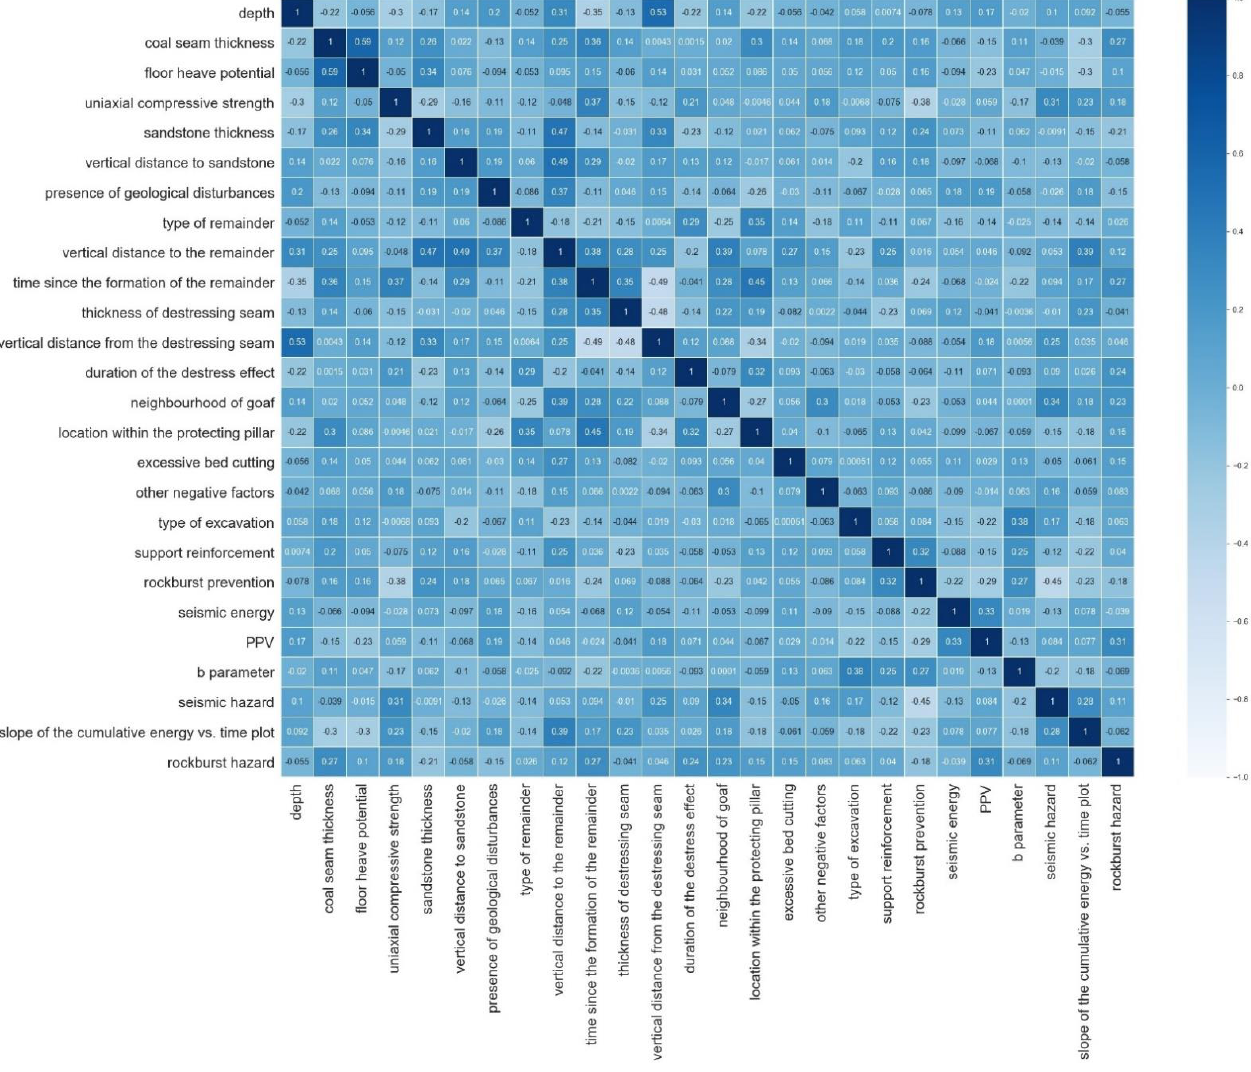
Figure A3. The correlation matrix of Pearson’s correlation coefficients of indicators related to the occurrence of rockbursts.